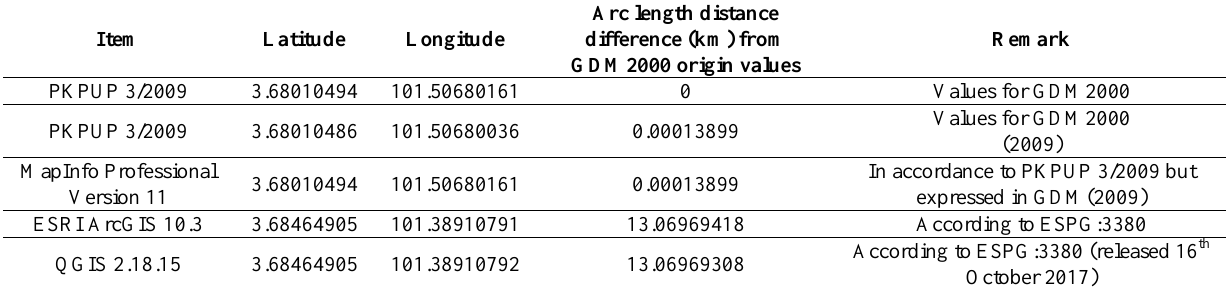
Table 3: Bukit Asa’s Origin Value